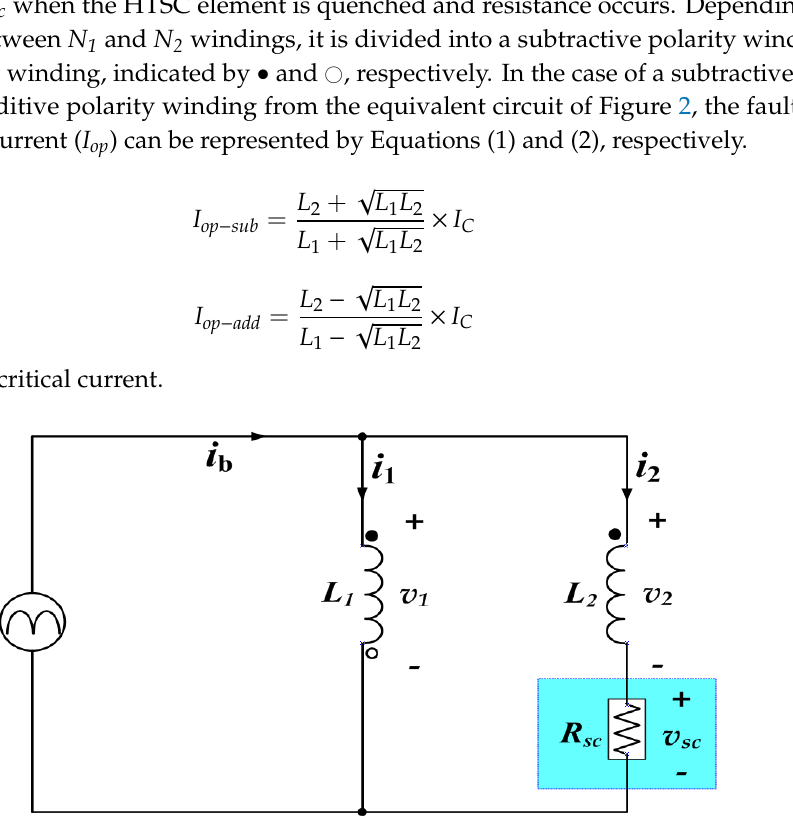
Figure 2. Equivalent circuit of bridge type SFCL with a single HTSC element using flux-coupling.